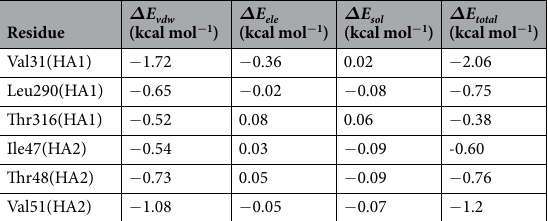
Table 2. Decomposition of binding energy on per residue basis on INT-HA under neutral conditions.